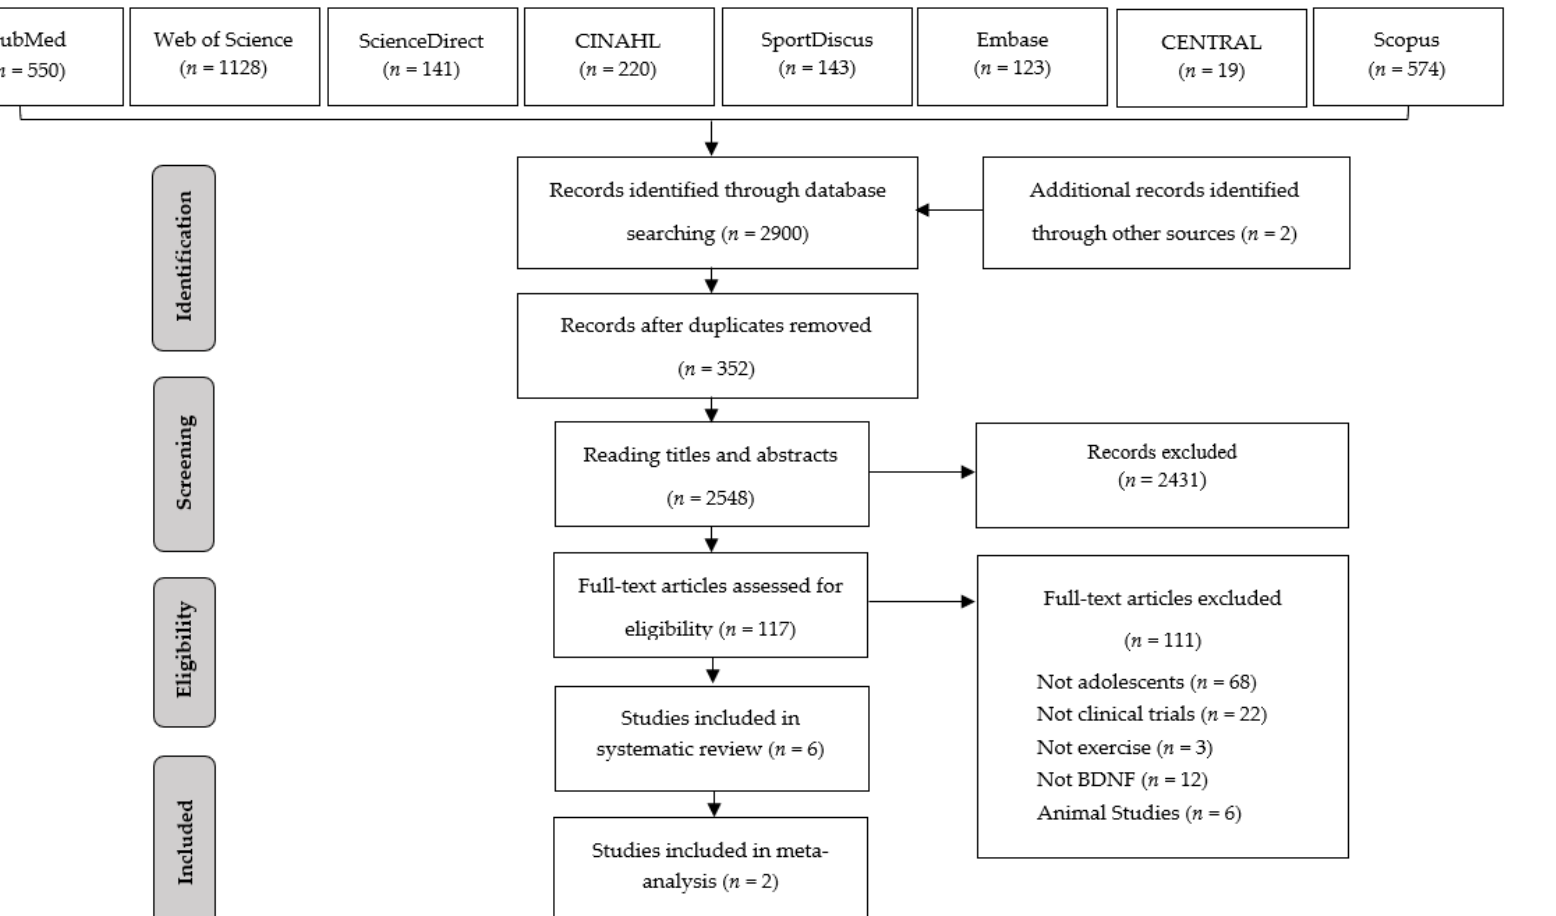
Figure 1. Article selection flowchart. Adapted from Preferred Reporting Items for Systematic Reviews and Meta-Analyses (PRISMA).